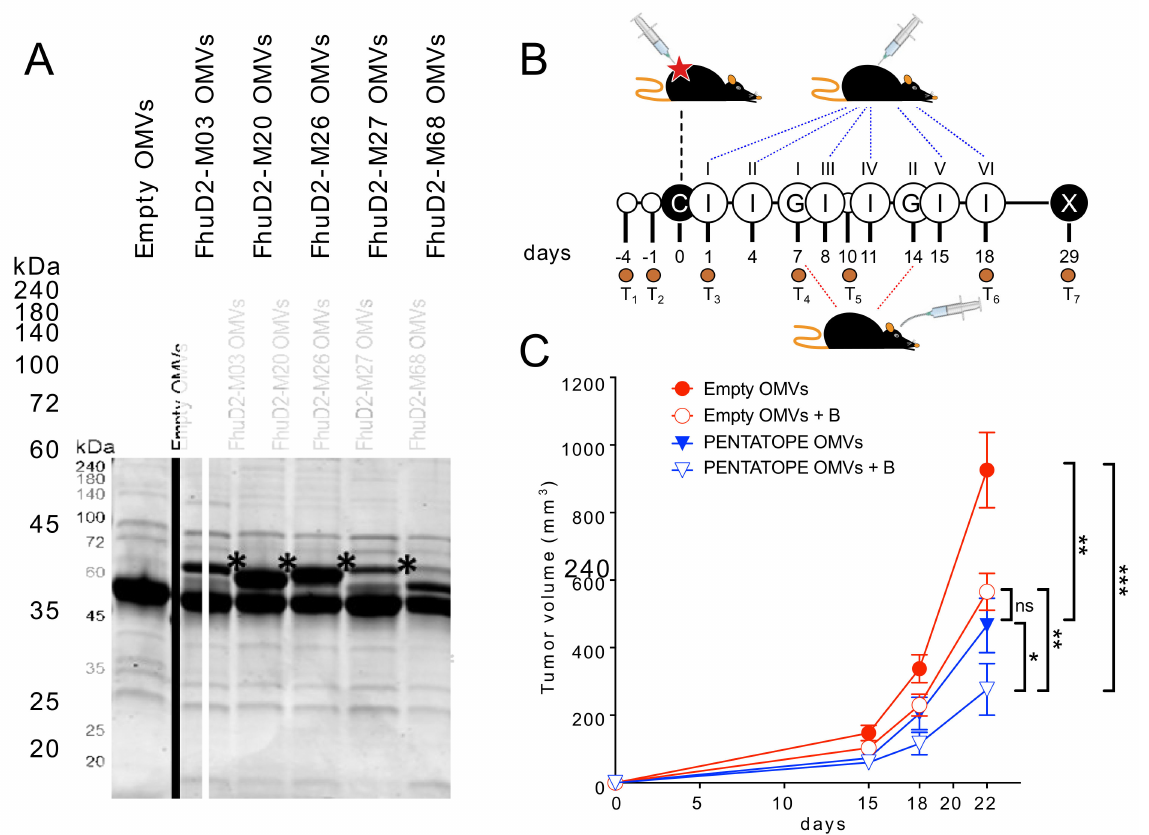
Figure 2. Effect of engineered OMV vaccination and Bifidobacterium administration on tumor growth inhibition. ( A ) SDS-PAGE analysis of engineered OMVs. M03, M20, M27, M68, M26 peptides were fused to the C-terminus of FhuD2 and the plasmids expressing the fusion proteins were used to transform E. coli BL21(DE3) ∆ ompA strain. OMVs were purified from the supernatant of the recombinant clones and 20 µ g of each OMV preparation were analyzed by SDS-PAGE. Stars indicate the bands corresponding to each fusion protein. ( B ) Schematic representation of animal treatment. Four groups of BALB/c mice (5 mice/group, two independent experiments) were injected with 1.5 × 10 5 CT26 cells (“C”) into the right flank. The day after challenge, two groups were vaccinated (“I”) every three days with 20 µ g of OMVs while the other two groups were injected with a mixture (4 µ g each) of the five engineered OMVs (20 µ g in total). At day 7 and 14 from tumor challenge, mice from one group immunized (“I”) with OMVs and one group immunized with engineered OMVs were given two oral gavages of Bifidobacterium cocktail. T1-7 correspond to the days when fecal samples were collected for microbiome analysis (see text and Figure 3). X, end of the experiment. ( C ) Analysis of tumor development. The tumor growth in mice treated as described in ( A ) was followed by measuring the tumor volume (mean ± s.e.m.) over a period of 22 days from challenge. Statistical analysis was performed using ANOVA and unpaired, one-tailed Student’s t -test. * p < 0.05; ** p < 0.01; *** p < 0.001. ns, not